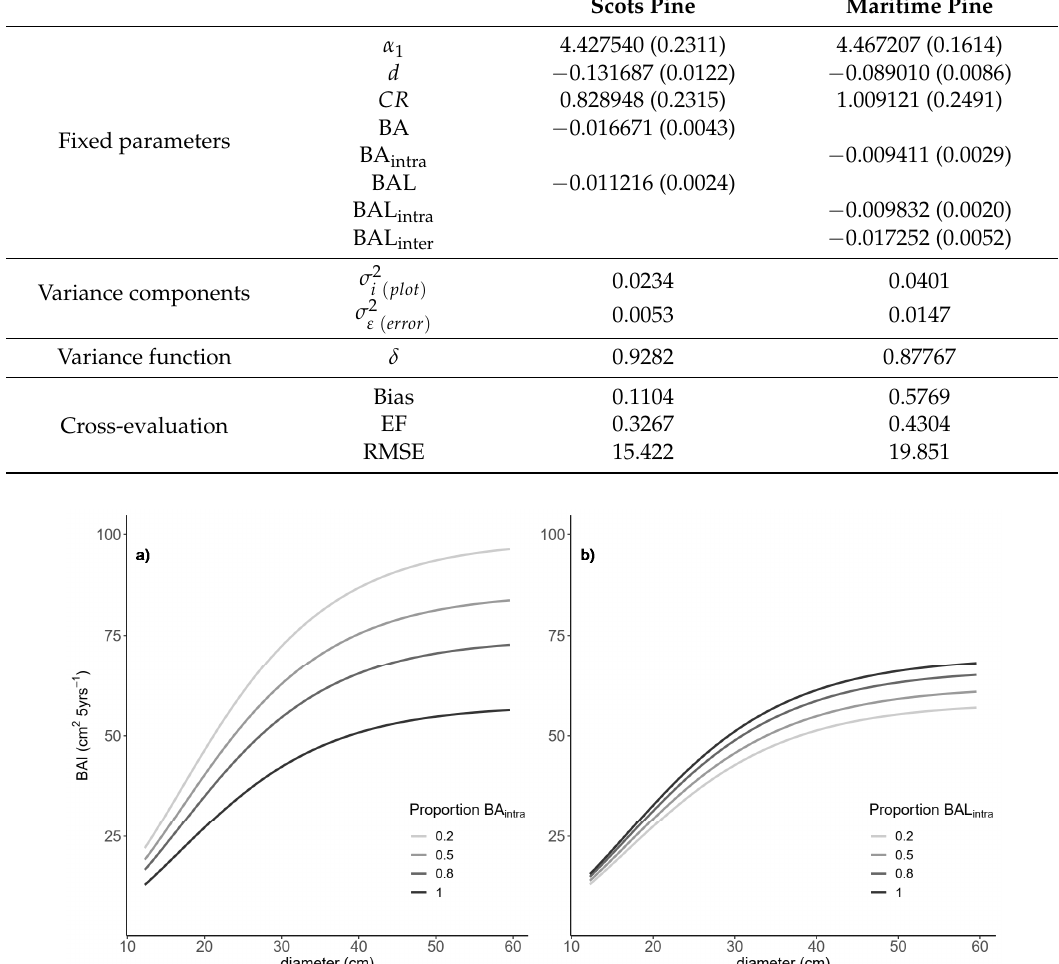
Table 5. Estimated parameters (standard errors in brackets) and fitting statistics for the final basal area increment models of the two species. Parameters were estimated by the restricted maximum likelihood method (REML). Variables are defined as follows: σ 2 ε , residual variance; σ 2 , variance for the i plot random effects; δ , parameters of the variance function (Equation (5)). Bias, EF, and RMSE are the the plot random effects; (cid:2012) , parameters of the variance function (Equation (5)). Bias, EF, and RMSE mean bias model efficiency and root mean square (Equations (8)–(10)), respectively. are the mean bias model efficiency and root mean square (equations (8)–(10)), respectively. Scots Pine Maritime Pine Scots Pine